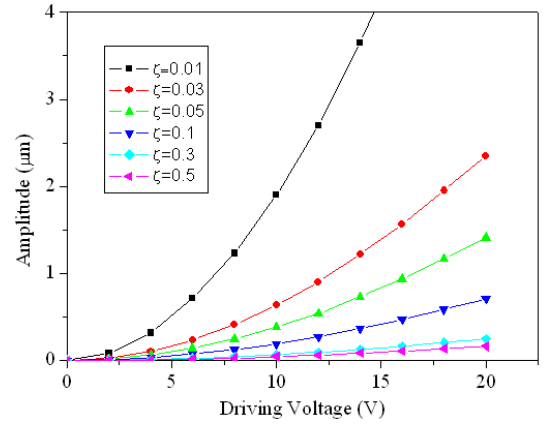
Figure 2. Maximum amplitude of the tunable resonator at different damping